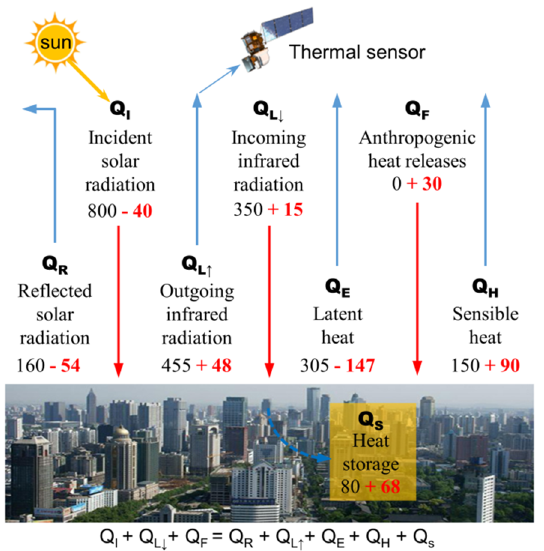
Figure 4. A diagram of the energy balance for a hypothetical urban area. Red and blue arrows designate energy input and partition in the urban system, respectively. The example values (units: W m − 2 ) were from Oke [132]. The values in red represent the energy change in the urban region relative to rural areas.